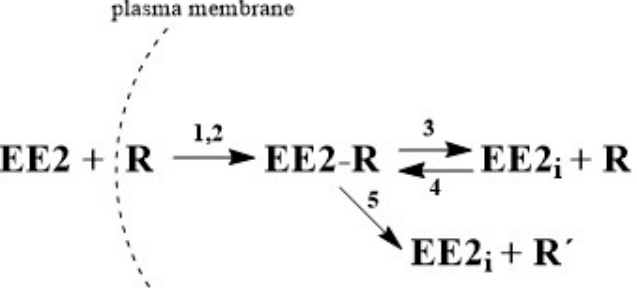
Figure 2. Simplified process of the interaction between hormone and sperm receptor, where EE2 is the extracellular hormone, R is the active sperm receptor, EE2-R is the adduct, EE2 i is the internal unbound hormone and R’ is the inactive sperm receptor; 1 and 2 represent rate constants of the non-autocatalytic (1) and autocatalytic (2) formation of EE2-R which are ongoing simultaneously, 3 and 5 represent rate constants of adduct decomposition, and 4 represents the rate constant of the back reaction.